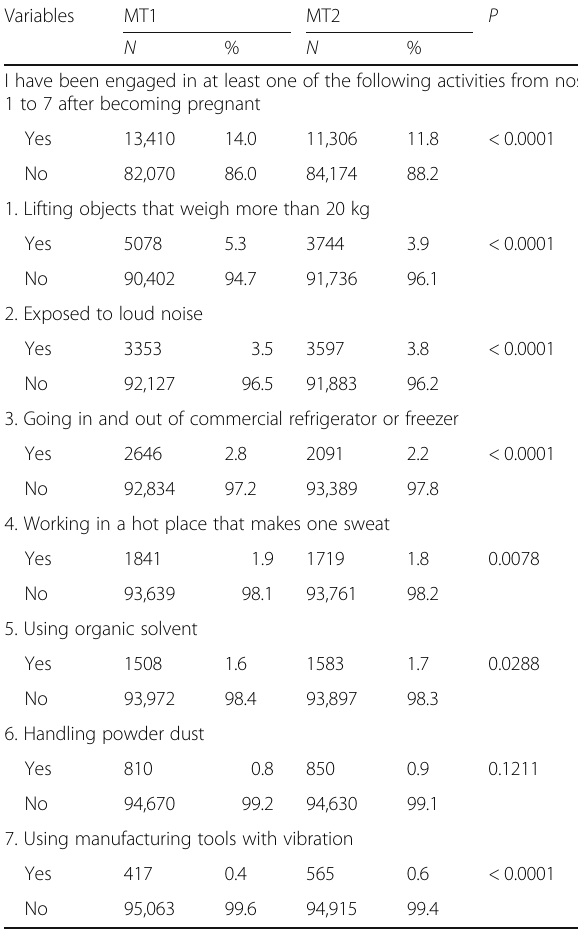
Table 1 Characteristics of workload from workplace, hobbies, and household during pregnancy as reported via two questionnaires of the MT1 and MT2 in the Japan Environment and Children ’ s Study